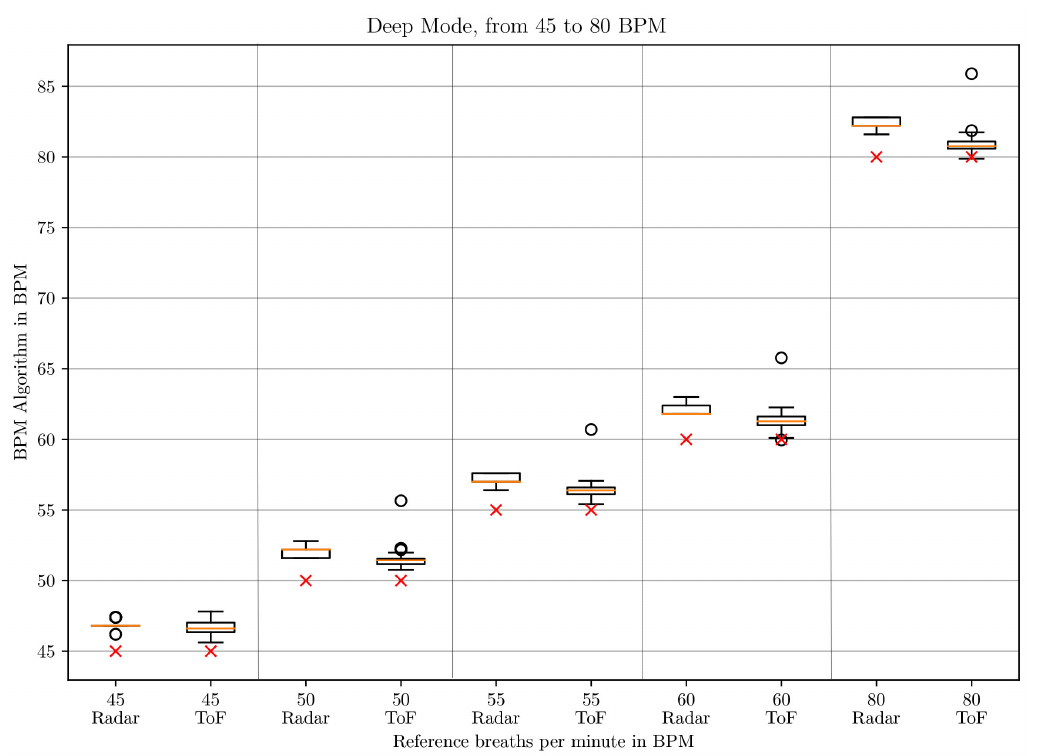
Figure 11. Box plot comparing the BPM values of the ToF and the radar algorithm for respiratory rates between 45 and 80BPM in deep